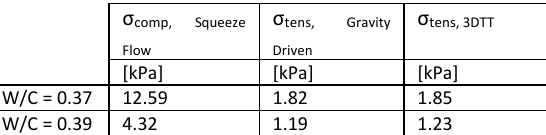
Table 3. Summary of the tensile strength obtained with 3DTT and gravity driven self ‐ traction tests. Comparison with compressive strength measured using squeeze